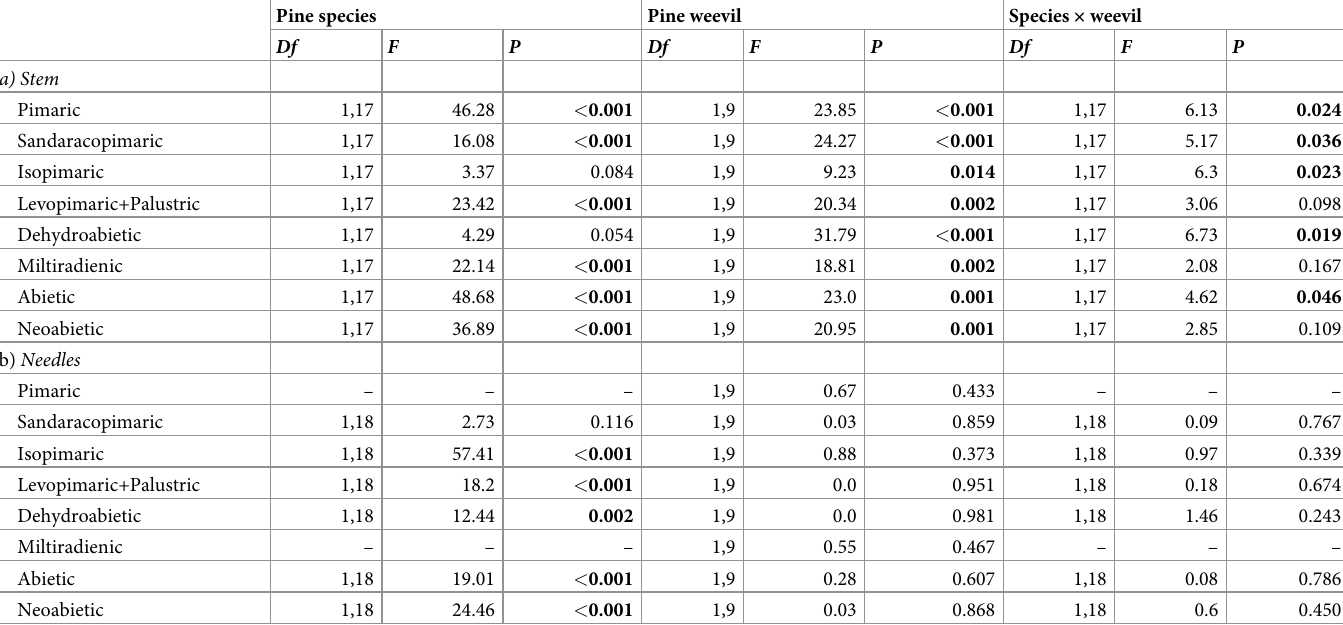
Table 3. Effects of the pine weevil feeding on the concentration of the main resin acids in the stem (a) and in the needles (b) tissues of two pine species. Pine